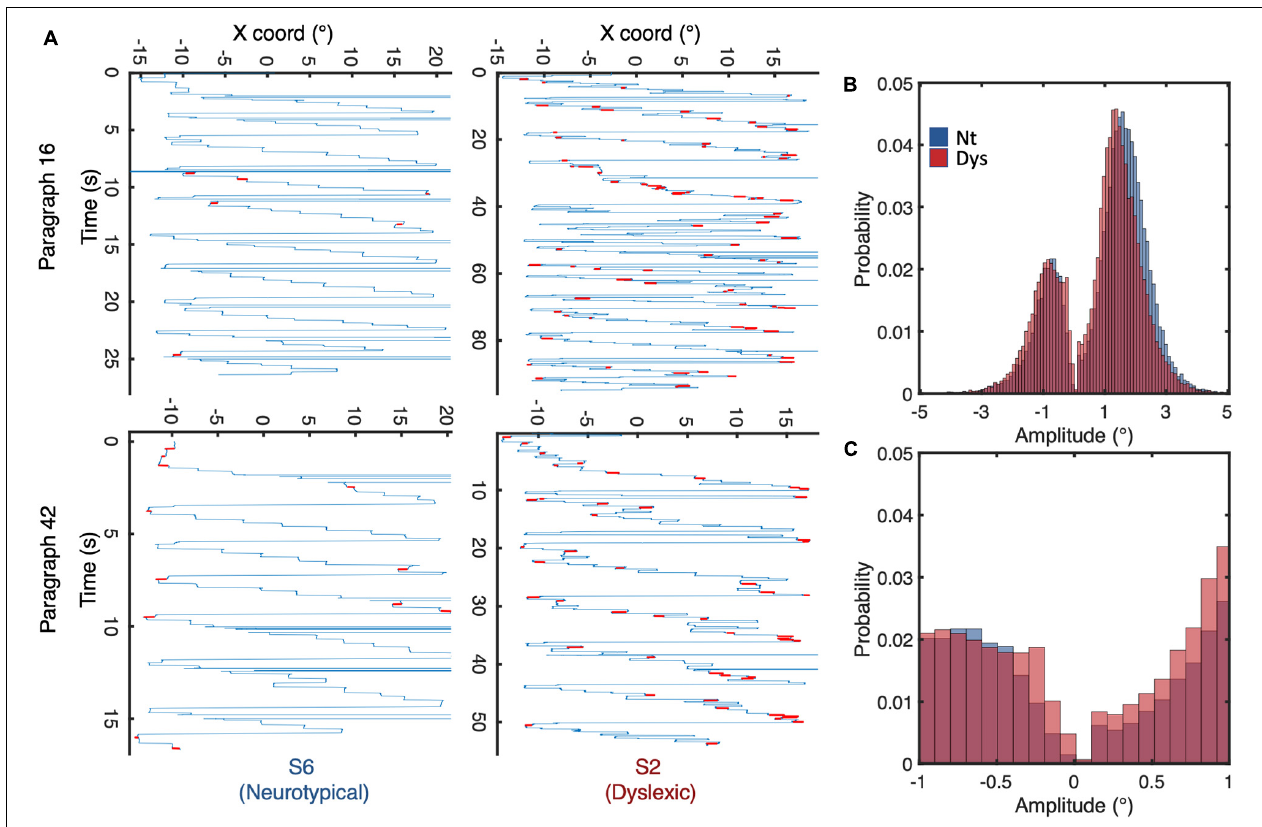
FIGURE 3 | (A) Eye movement scan paths of a neurotypical reader (left panel) and dyslexic reader (right panel) while reading identical paragraphs of a short story. (B) Saccadic amplitude distributions for neurotypicals (blue) and dyslexics (red) during reading. (C) Distribution of saccade amplitudes < 1. Negative/positive amplitudes indicate saccades to the left/right of fixation,